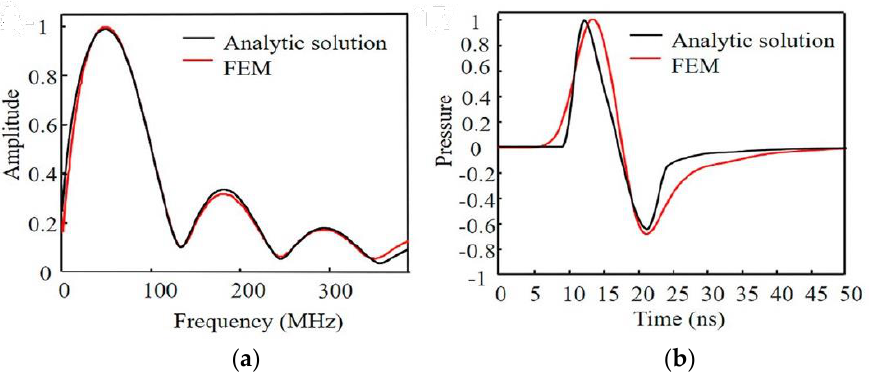
Figure 16. Ultrasound wave generated through the photoacoustic effect in a model developed in COMSOL Multiphysics compared against an analytical solution: ( a ) over time; ( b ) over frequency. Reproduced with permission from [154].